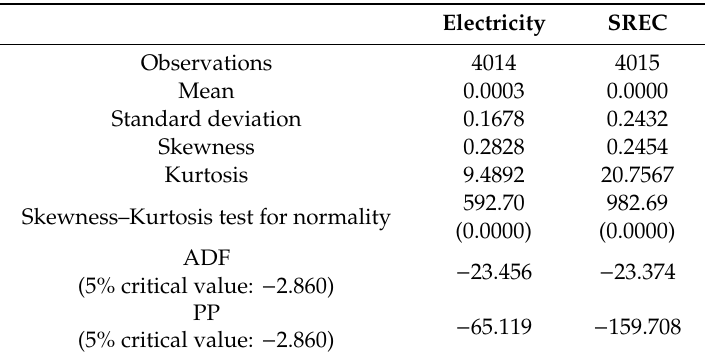
Table 2. Descriptive statistics of log